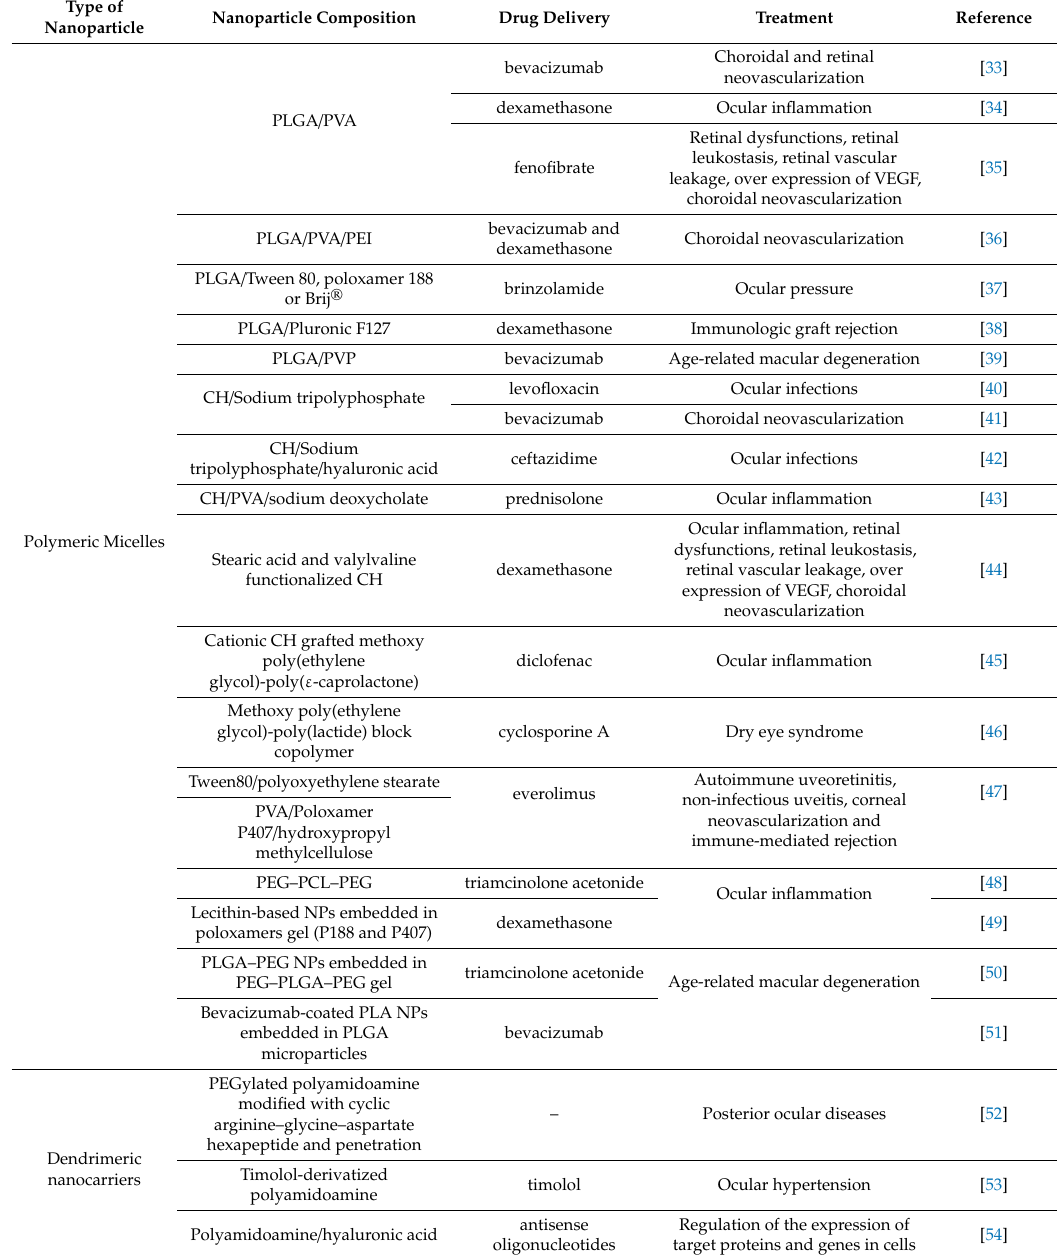
Table 1. Polymeric micelles used for drug delivery, drug encapsulated and disease for which they are